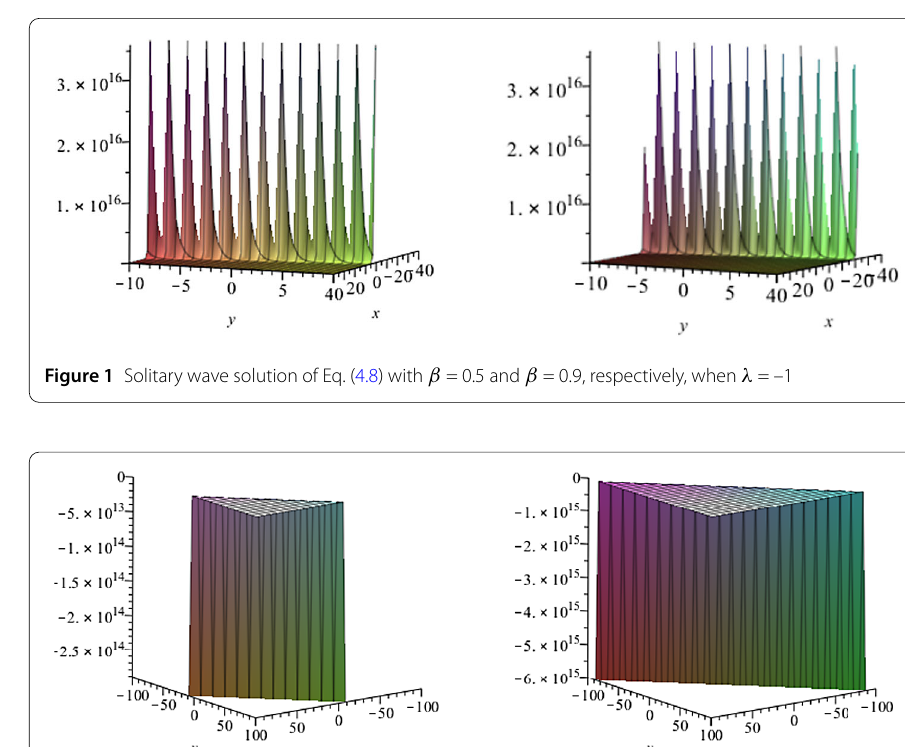
G (cid:2) , 1 )-expansion method is G G